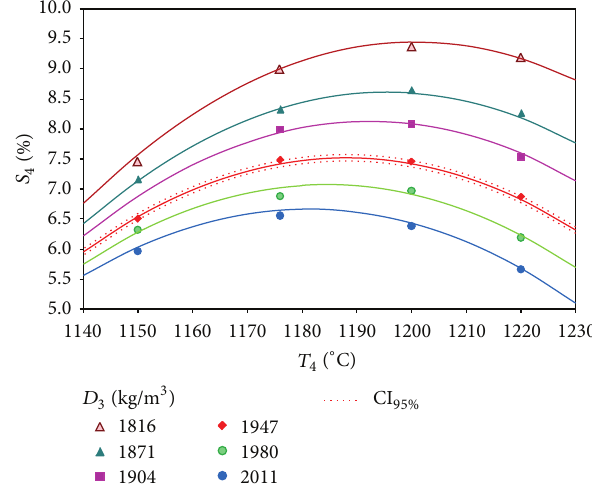
Figure 9: Linear firing shrinkage ( 𝑆 4 ) as a function of the maximum firing temperature ( 𝑇 4 ) and dry bulk density ( 𝐷 3 ).